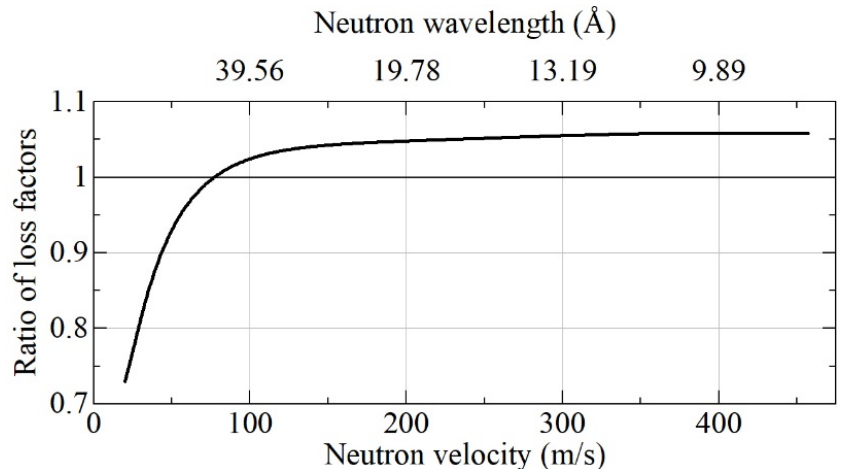
Figure 7. Ratio of loss factors η _(DF-DNDs)/ η _(S-DNDs) at reflection from flat semi-infinite media of DF-DNDs and S-DNDs as a function of neutron velocity. The respective neutron albedo is shown in Figure 6.